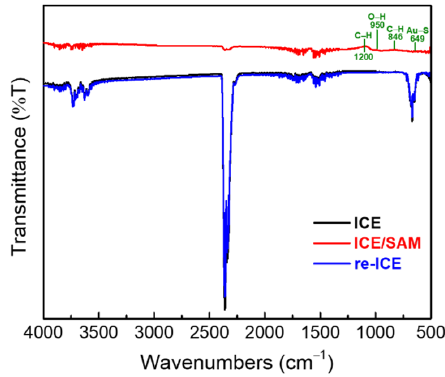
Figure 4. FT ‐ IR results of the ICE, ICE/SAM, and re ‐ ICE. Figure 4. FT-IR results of the ICE, ICE/SAM, and